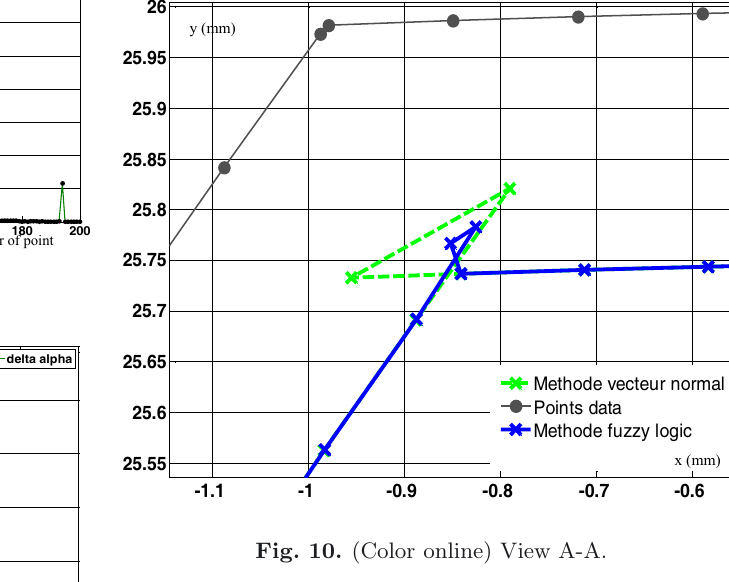
Fig. 10. (Color online) View A-A.